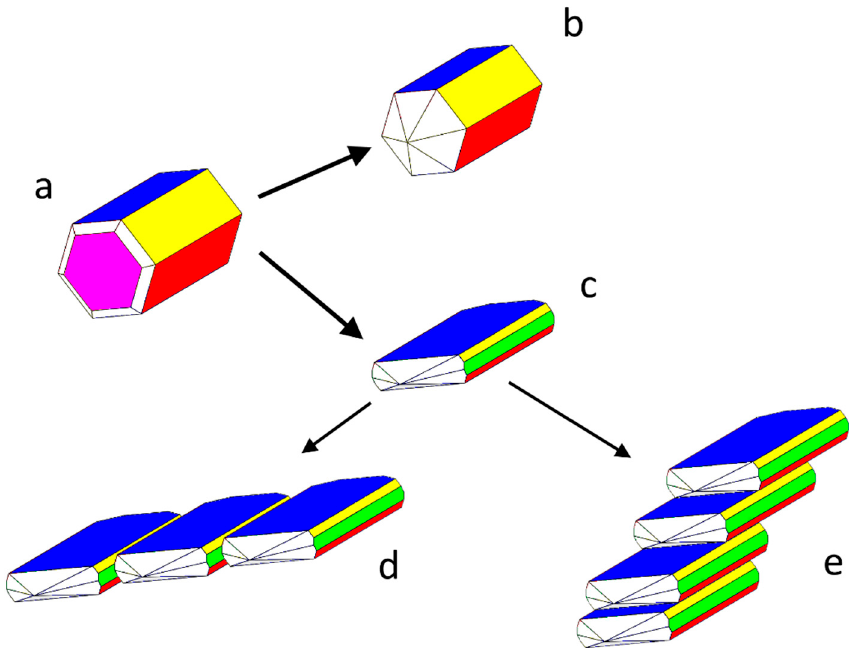
Figure 3. ( a ) Calculated equilibrium shape of the monoclinic HAp crystal: the pseudo ‐ hexagonal prismatic shape is built up by the pinacoids {001} ‐ blue, {100} ‐ yellow, and (cid:4668)102(cid:4669) ‐ red. The {010} ‐ purple pinacoid limits the pseudo prismatic development [31]. ( b ) Experimental growth shape in pure aqueous solution. ( c ) Experimental growth shape in the presence of citrate: a part of the platy aspect, a new (cid:4668)101(cid:4669) ‐ green appears and, according to Figure 2, the elongated HAp platelets do nucleate successively, giving rise to complex arrangements, welded either on the (cid:4668)101(cid:4669) or {001} faces (or both, as drawn in Figure SI4), respectively represented in ( d,e ).